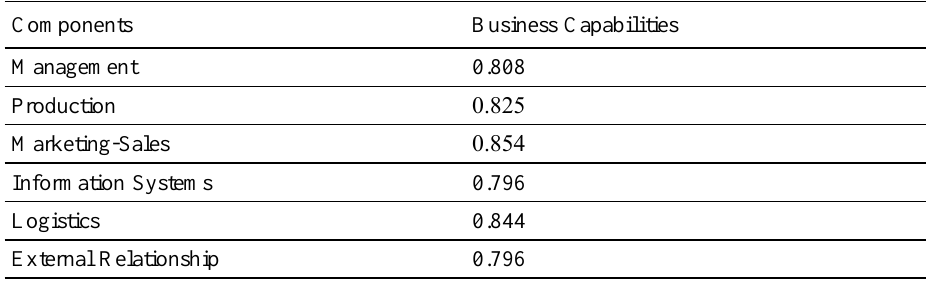
Table 3. The result of the second order factor loadings of